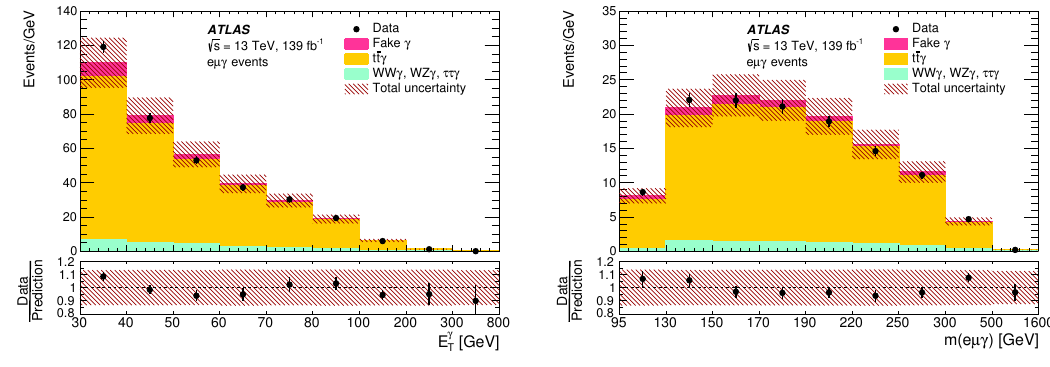
Figure 4 . Distributions of (left) E (cid:13) and (right) m ( e(cid:22)(cid:13) ) for selected e (cid:6) (cid:22) (cid:7) (cid:13) events. The number of T candidates observed in data (black data points) is compared with the sum of the expectation from t (cid:22) t(cid:13) , WW(cid:13) , WZ(cid:13) , (cid:28) + (cid:28) (cid:0) (cid:13) and fake-photon background. The lower panel in each plot shows the ratio of the observed and expected distributions. The error bars on the observed distribution, and on the ratio of the observed distribution to the expected distribution, show the statistical uncertainty due to the number of observed events. The hatched bands represent the total uncertainty on the expected